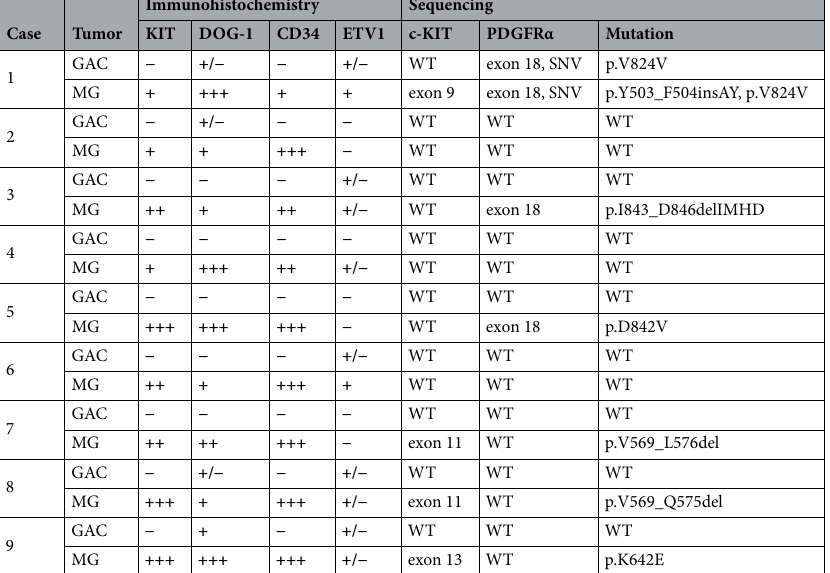
Table 2. Immunohistochemical analyses of GIST markers and c-KIT/PDGFRα mutational status of the tumors. GAC gastric adenocarcinoma, MG microscopic gastrointestinal stromal tumor (micro-GIST), DOG1 discovered on GIST-1, ETV1 ETS translocation variant 1 protein, PDGFRα platelet-derived growth factor-α, SNV single nucleotid variant, WT wild